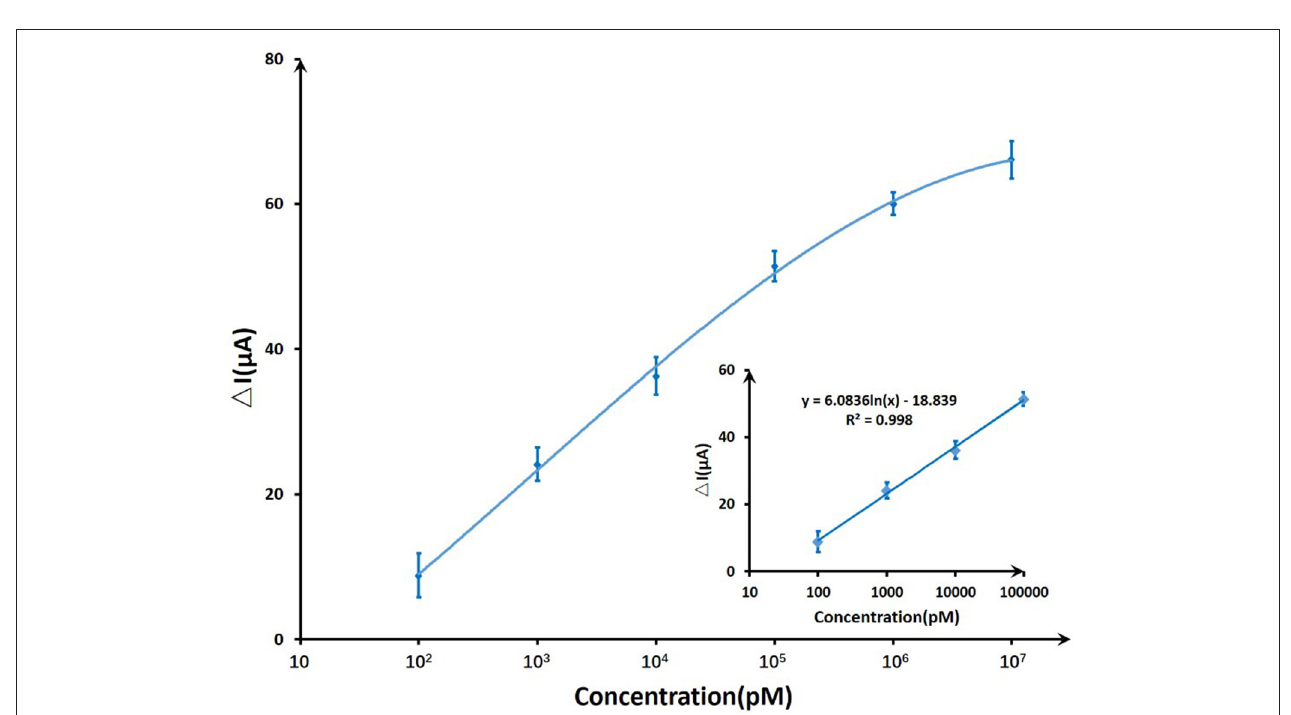
FIGURE 8 | The sensitivity trendline of DNA-based GFET array biosensor to mercury ions ranging from 100pM to 10 µ M. A linear fit was given for the first four concentrations.